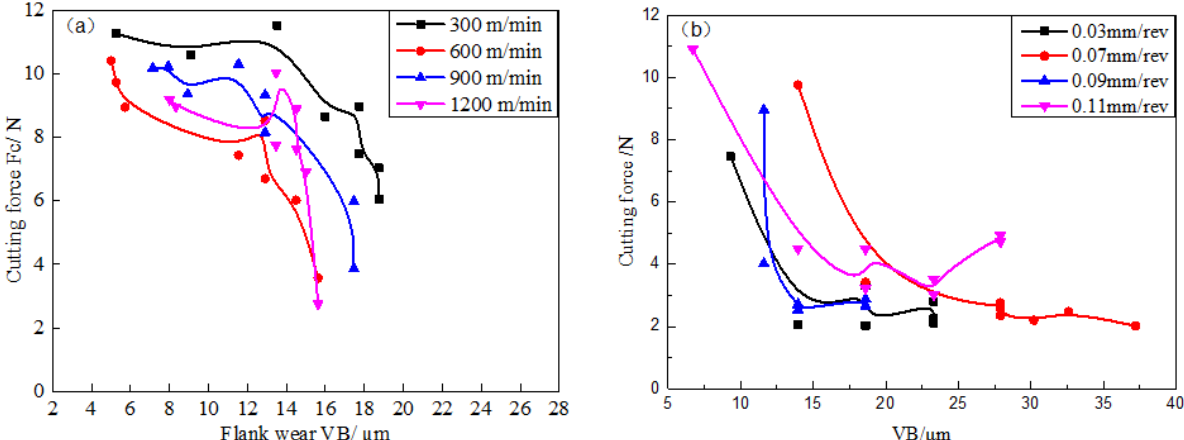
Figure 12. The relationship between cutting force and wear land width (VB) at different ( a ) cutting speed (where feed is 0.05 mm/rev, cutting depth is 0.5 mm and cutting width is 3 mm); ( b ) feed (where cutting speed is 900 m/min, cutting depth is 0.5 mm and cutting width is 3 mm).